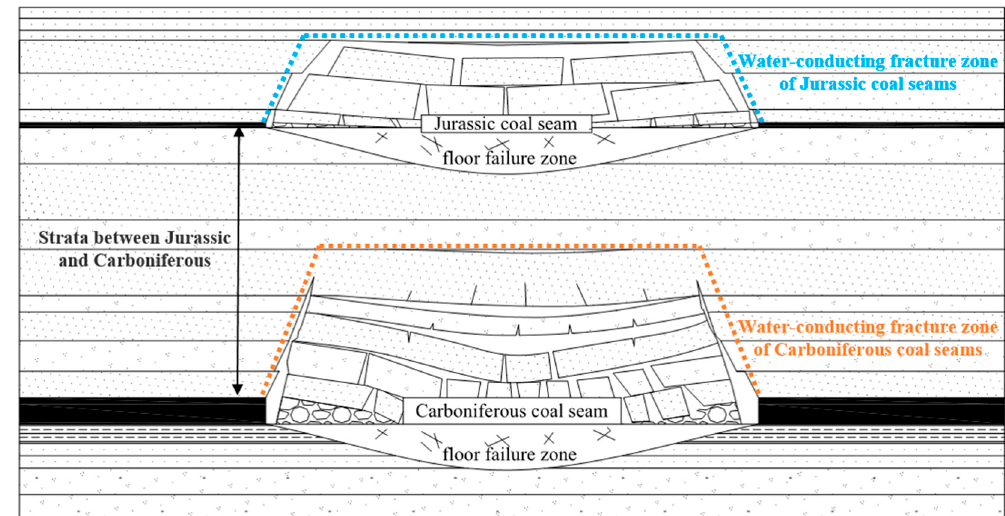
Figure 1. The distribution map of water-conducting fracture zone in overburdened rock.